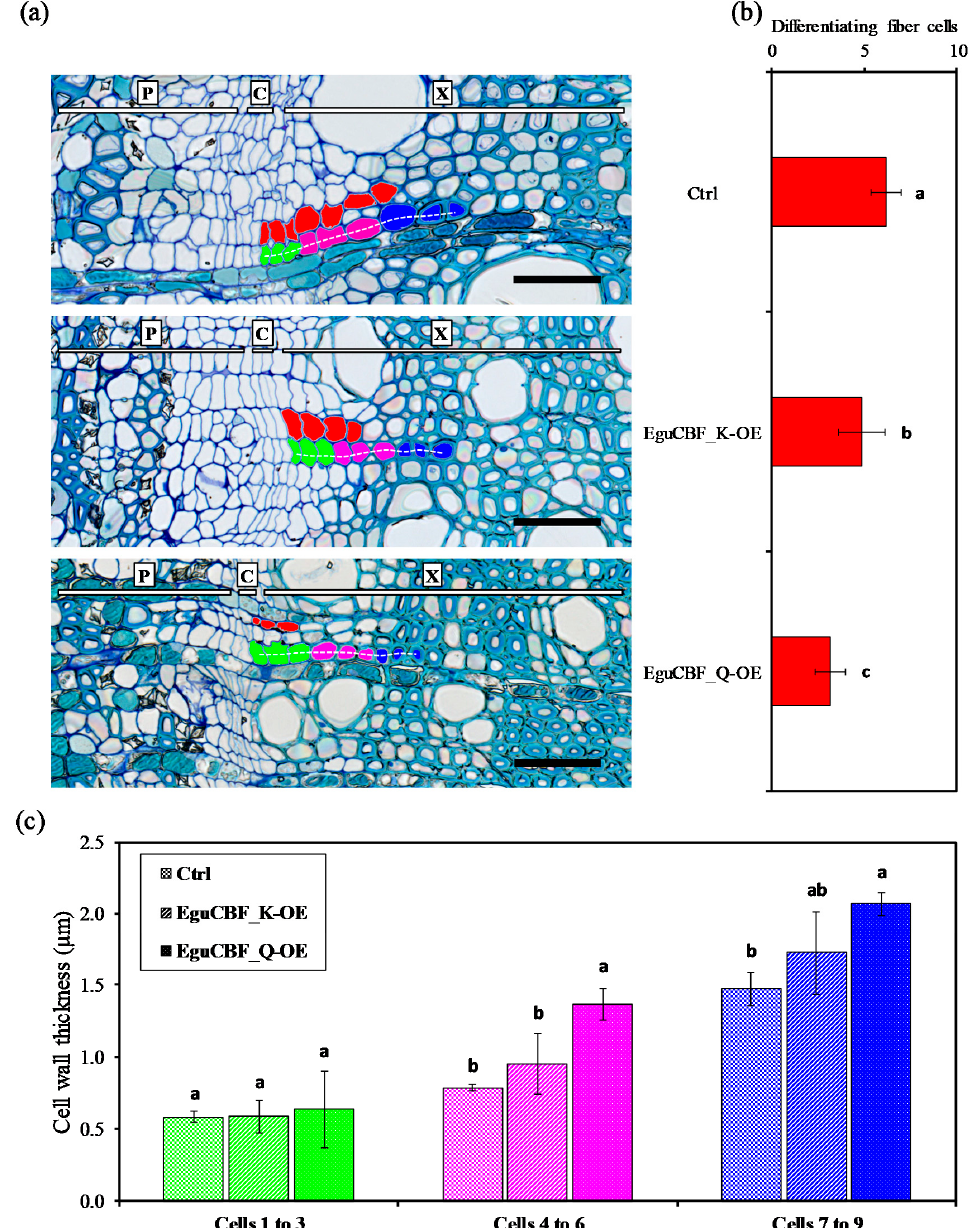
Figure 3. Dynamics of xylem differentiation in the CBF -overexpressing lines and controls. ( a ) Stem cross sections of 6-month-old controls, EguCBF_K -OE, and EguCBF_Q -OE Eucalyptus plants stained with Toluidine blue O. Differentiating xylem cells with thin primary cell walls are colored in red. A cell line originating from the same cambial initial was artificially separated into three groups (green, cells 1 to 3; pink, cells 4 to 6; blue, cells 7 to 9) ( b ) Average number of differentiating fiber cells (colored in red) from cambial initials, counted on 49 to 61 fiber cell lines (i.e., fiber cells originating from the same cambial initial) as exemplified by the white dotted line, across 3 biological replicates per line. ( c ) Average cell wall thickness for each of the three groups (cells 1 to 3; 4 to 6; 7 to 9) of differentiating fiber cells starting from the cambial initials. The average cell wall thickness was measured on 31 to 58 fiber cell lines per line, across 3 biological replicates per line. The results are means ± SD of measurements (different fiber cell lines) and statistical difference was assessed using one-way